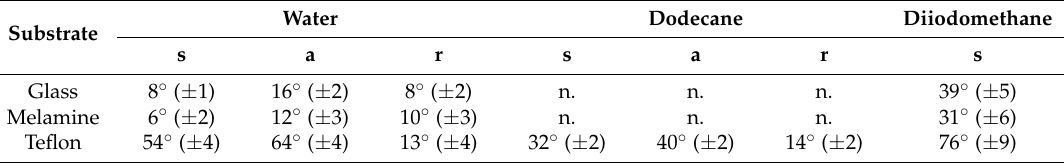
Table 5. Contact angle measurements of the substrates after modification with the Neodol 91-5 & SBA-15